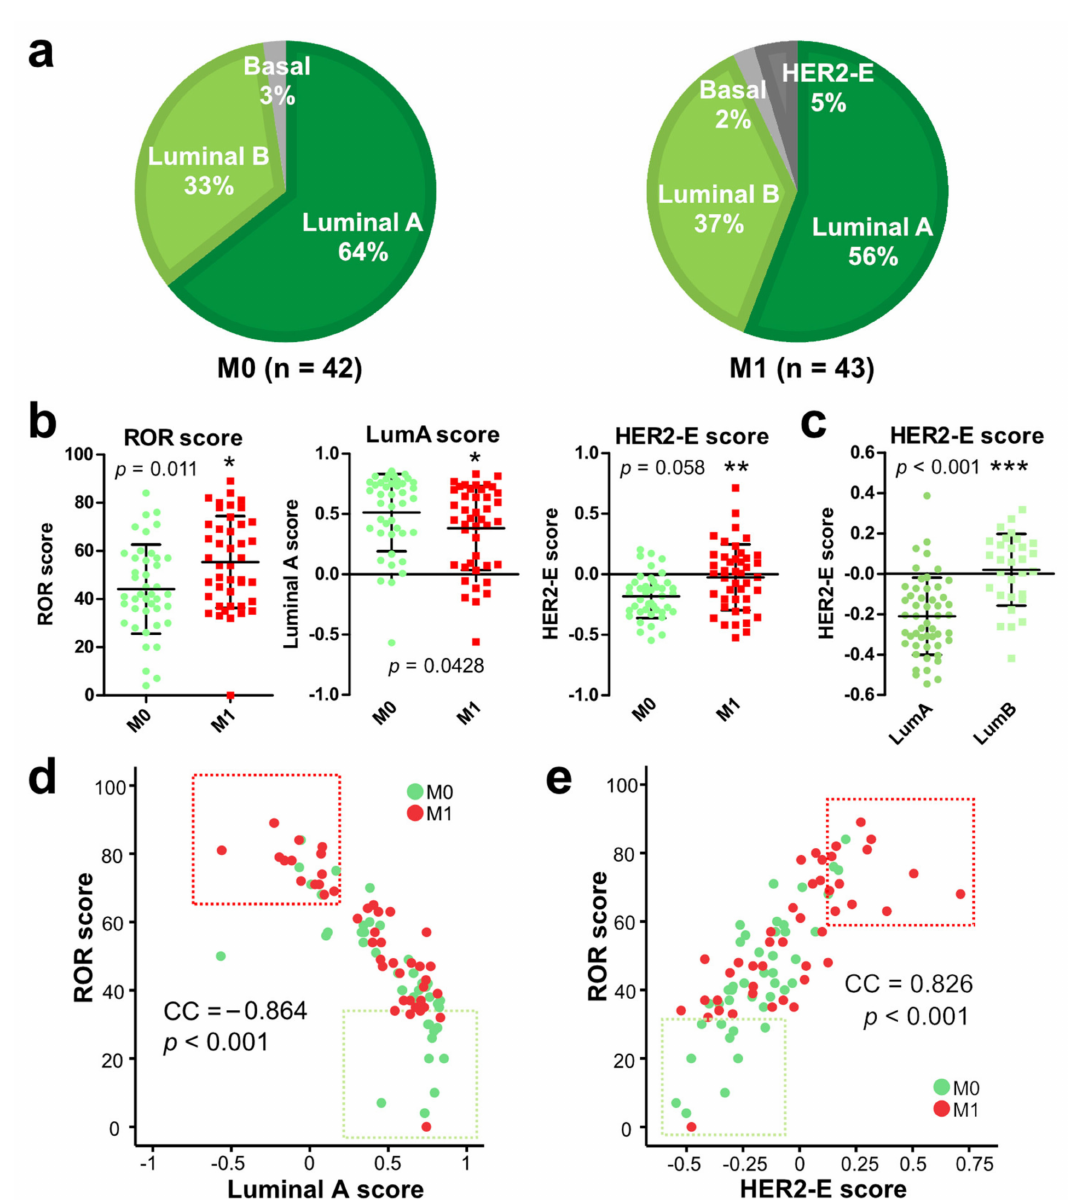
Figure 1. Molecular subtypes in premenopausal breast cancer patients with (M1) and without (M0) subsequent metastasis. ( a ) Proportion of patients in M0 and M1 groups with the indicated molecular subtypes. ( b ) Comparison of Luminal A, HER2-E, and ROR scores between M0 and M1 groups. *, p < 0.05, **, p < 0.01, ***, p < 0.001. ( c ) Comparison of HER2-E score between Luminal A (LumA) and Luminal B (LumB) groups. ( d , e ) Correlation of ROR score and Luminal A ( d ) or HER2-E ( e ) score. CC, Spearman correlation coefficient. p values are